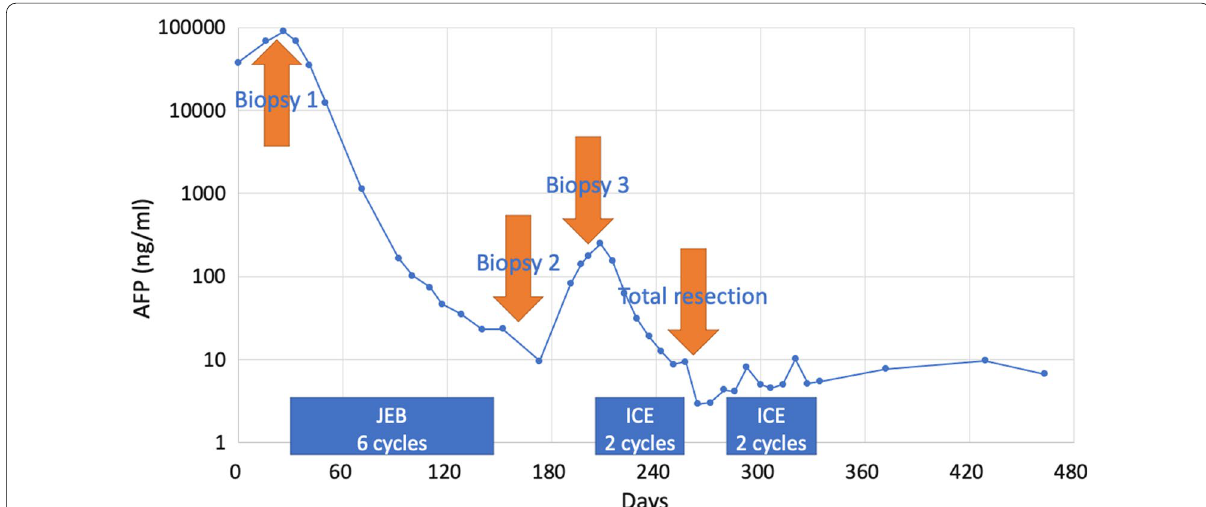
Fig. 2 Trend of AFP level and treatment timeline. Day 0 was the patient’s first visit. The AFP values (ng/mL) are plotted on a logarithmic scale. JEB and ICE are the chemotherapy regimens. AFP, alpha-fetoprotein; JEB, carboplatin, etoposide, and bleomycin; ICE, ifosfamide, carboplatin, and etoposide